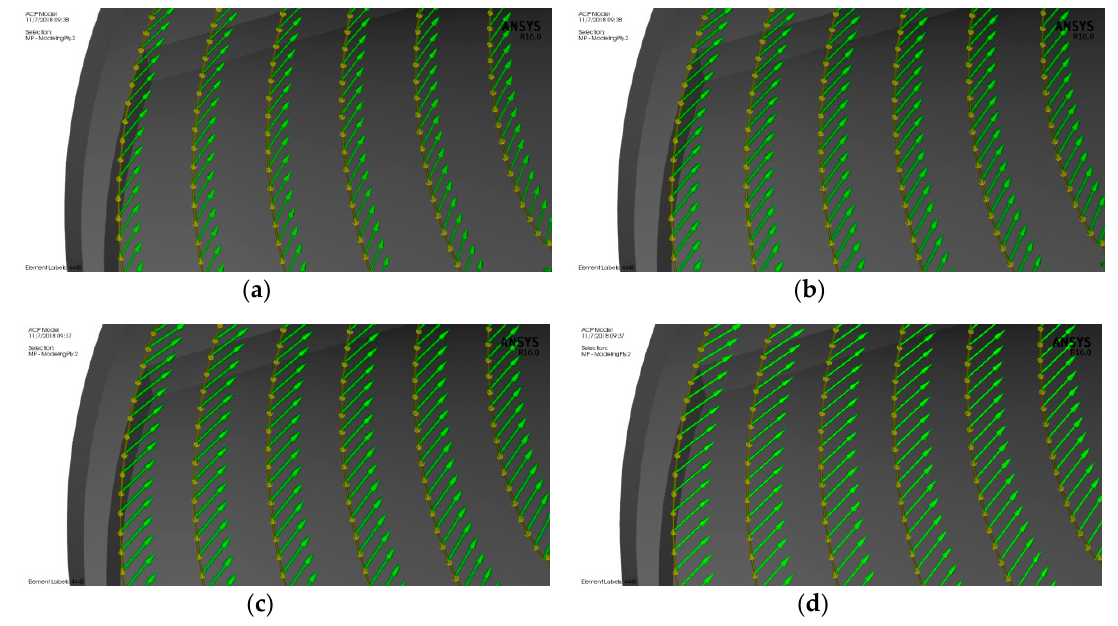
Figure 10. An ACP composite model for the rotor blade with different fiber orientations:( a ) 30° from the blade edge, ( b ) 40° from the blade edge, ( c ) 50° from the blade edge, and ( d ) 60° from the blade edge.